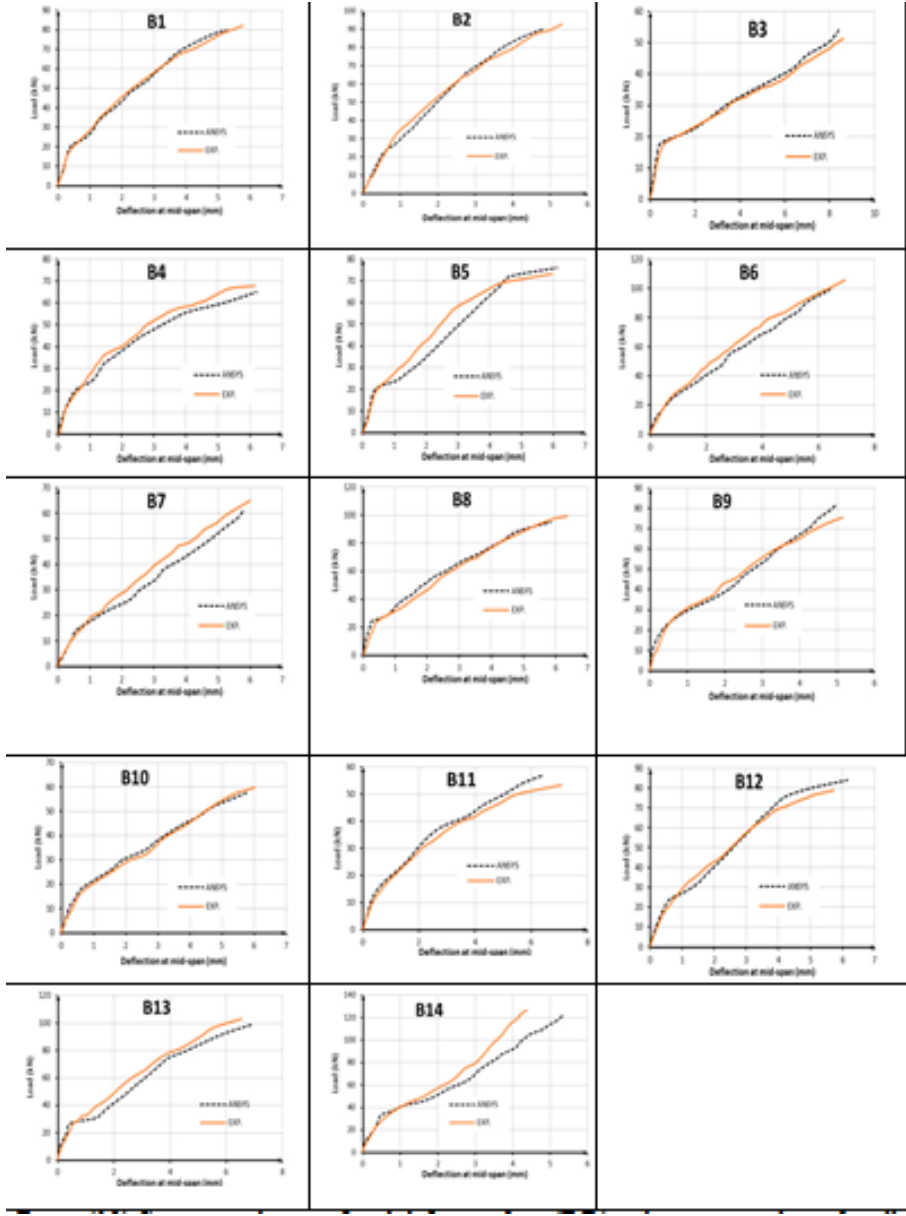
Figure 12: Comparison between Load-deflection from (F.E.) and experimental test for all